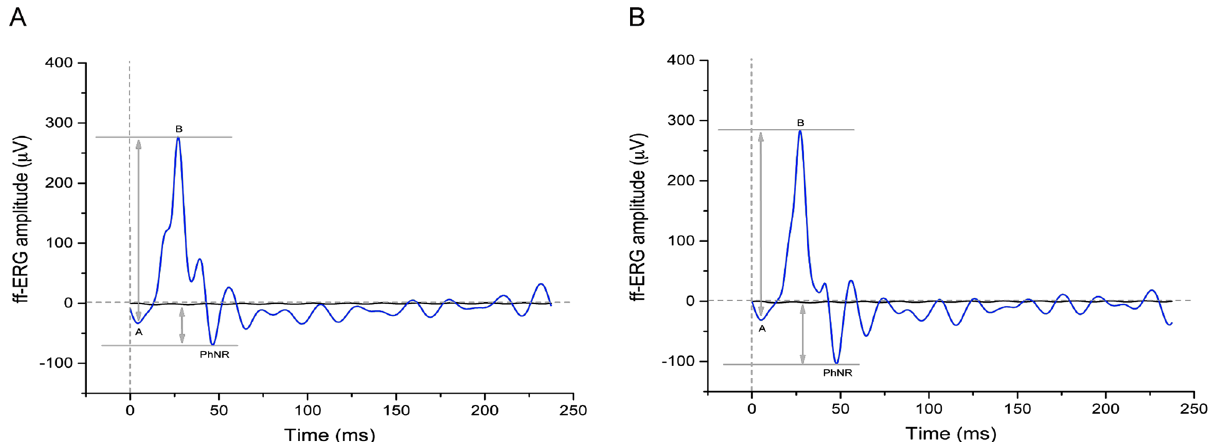
Figure 2. Representative ff-ERG traces for the first ( A ) and second ( B ) electrophysiological sessions. The morphology of the electrophysiological responses to flashes of light is similar but not identical between the two time points. Note that the ΔA-B response slightly increases in the second session, as does the PhNR response (midline to peak). A, a-wave; B, b-wave; PhNR, photopic negative response.